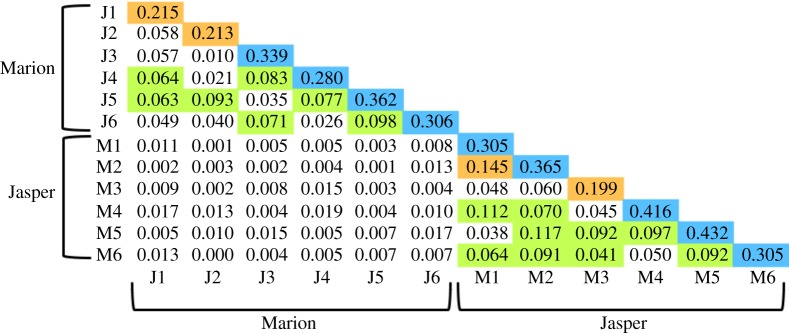
Pairwise relatedness estimates calculated among family groups of greater prairie chicken in Illinois. Calculations were based on 21 microsatellite loci. J1–J6 = family groups in Jasper County; M1–M6 = family groups in Marion County. Colours highlight relatedness values that exceed minimum values for the following relationships: blue = half-sib (r > 0.25); orange = first cousin (r > 0.125); green = second cousin (r > 0.0625).